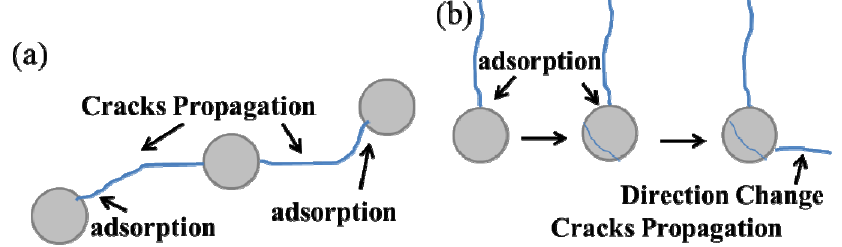
Figure 12. Schematic diagram of inhibiting effect of cracks propagation from UNPs: ( a ) cracks were stopped at the UNPs and crystalline region interface; ( b ) cracks entered the UNPs.